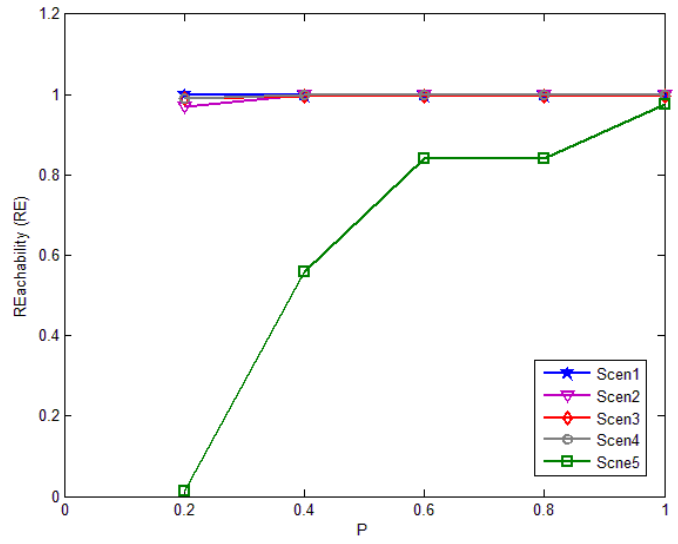
Figure 18. Reach ability in each scenario against threshold P.